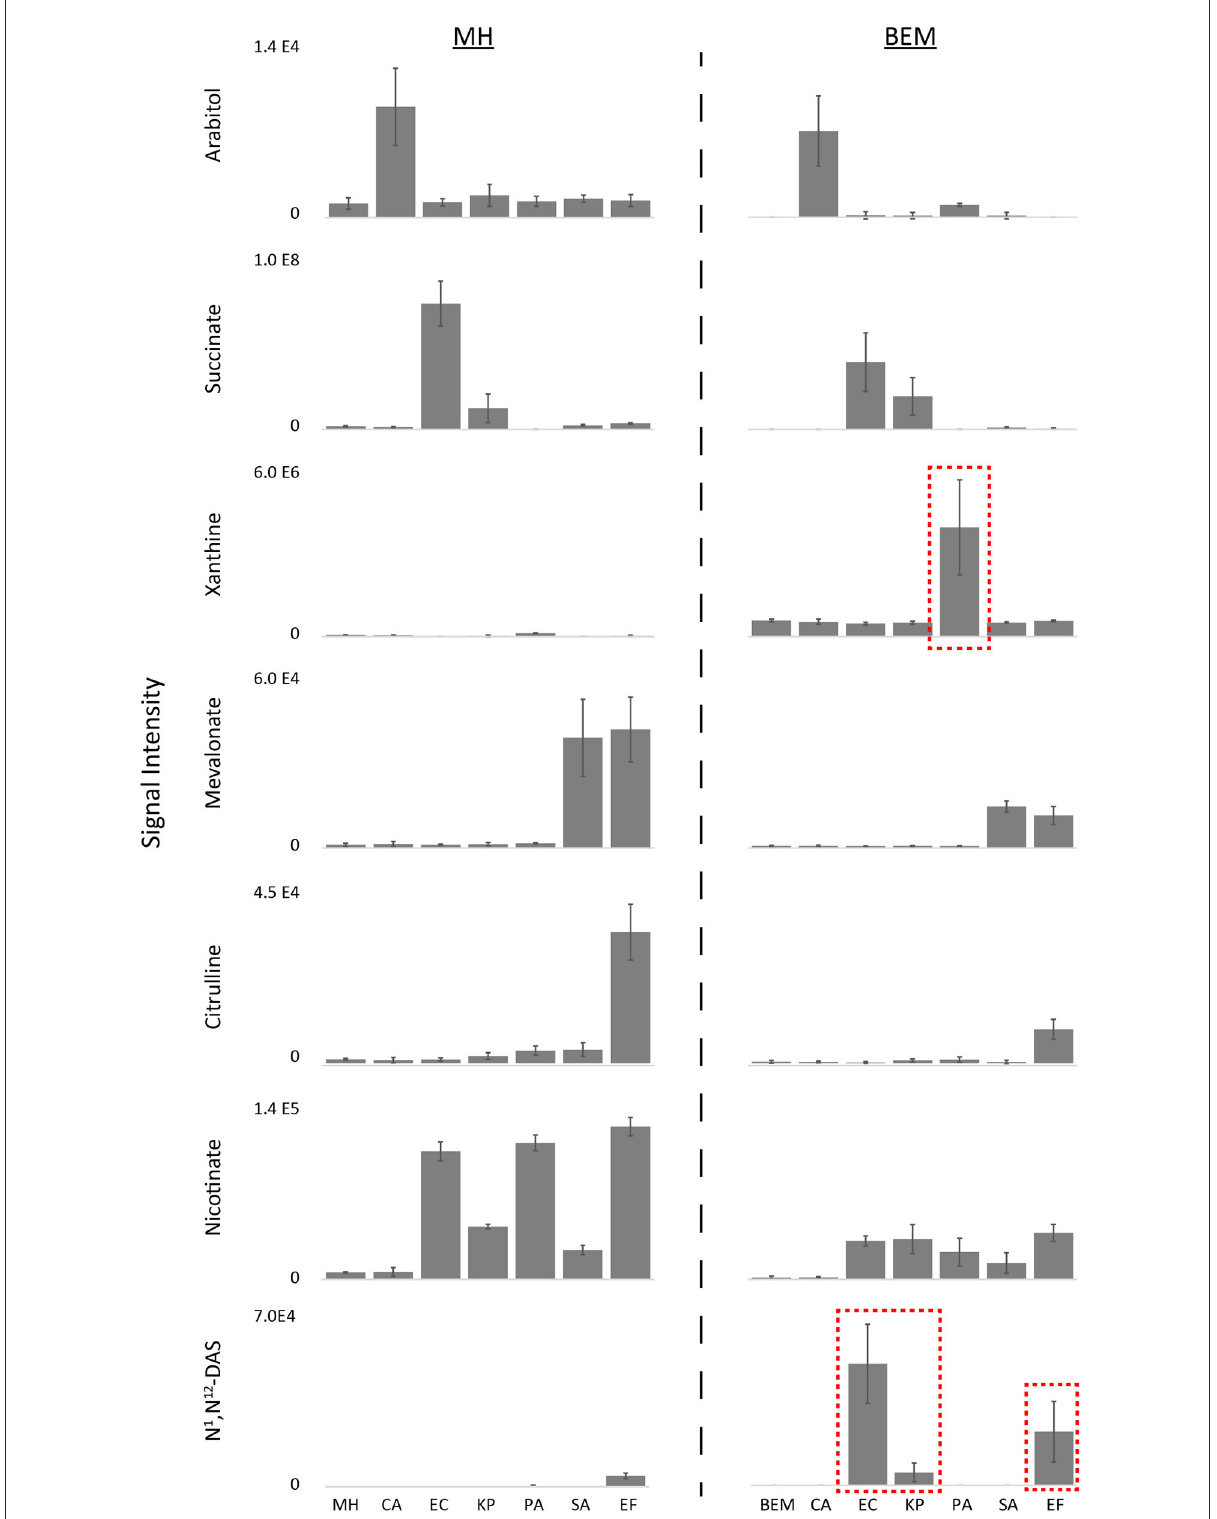
FIGURE7 Differential biomarker production of pathogens incubated in MH vs. defined BEM medium. Metabolic phenotypes of MH were reproduced in BEM. Notably, supplementation of hypoxanthine in BEM improved PA xanthine levels and addition of spermine resulted in improved N 1 ,N 12 -diacetylspermine production by EF, as well as EC and KP (Source Data File 3). Key biomarkers that are affected by medium have been highlighted in red boxes. MH, Mueller Hinton medium; BEM, Biomarker Enrichment Medium; CA , Candida albicans ; KP , Klebsiella pneumoniae ; EC , Escherichia coli ; PA , Pseudomonas aeruginosa ; SA , Staphylococcus aureus ; EF, Enterococcus faecalis . Data are presented as mean values + / − SD of n = 3